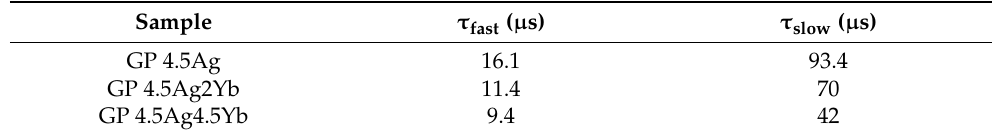
Table 3. PL decay lifetimes (fast and slow components) of Ag NCs: GP 4.5Ag, GP 4.5Ag2Yb, and GP